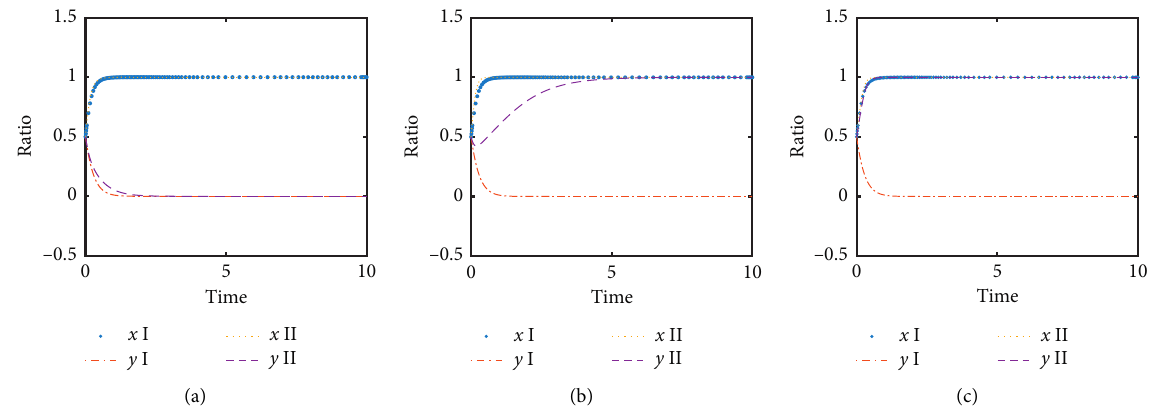
Figure 5: The influences of the change of knowledge level on the evolution system. (a) K (c) K g � 20 ,K s � 100.